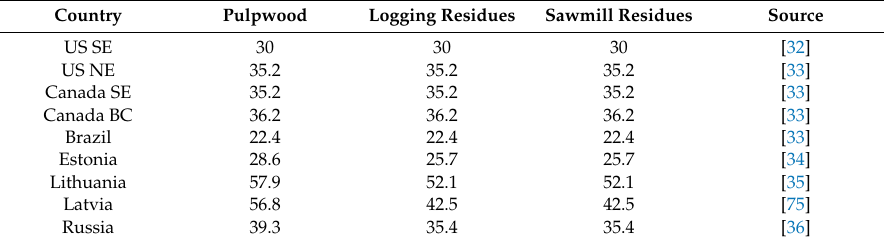
Table A1. Feedstock costs for the di ff erent feedstock types, in € / t of wet feedstock.